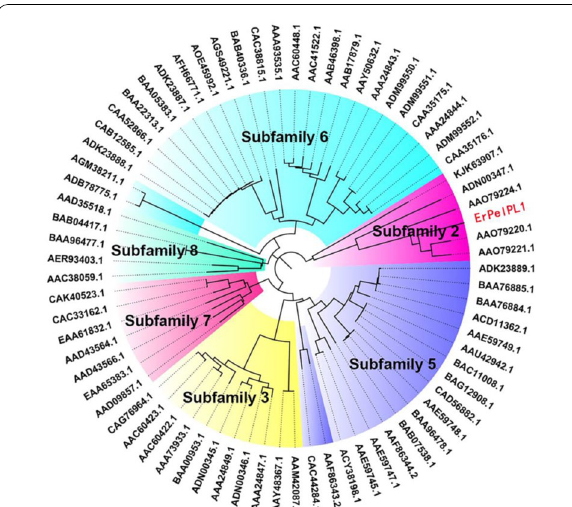
Fig. 1 Phylogenetic analysis of ErPelPL1 with other pectate lyases of PL1 family. Different color blocks correspond to subfamilies of PL1 family, respectively